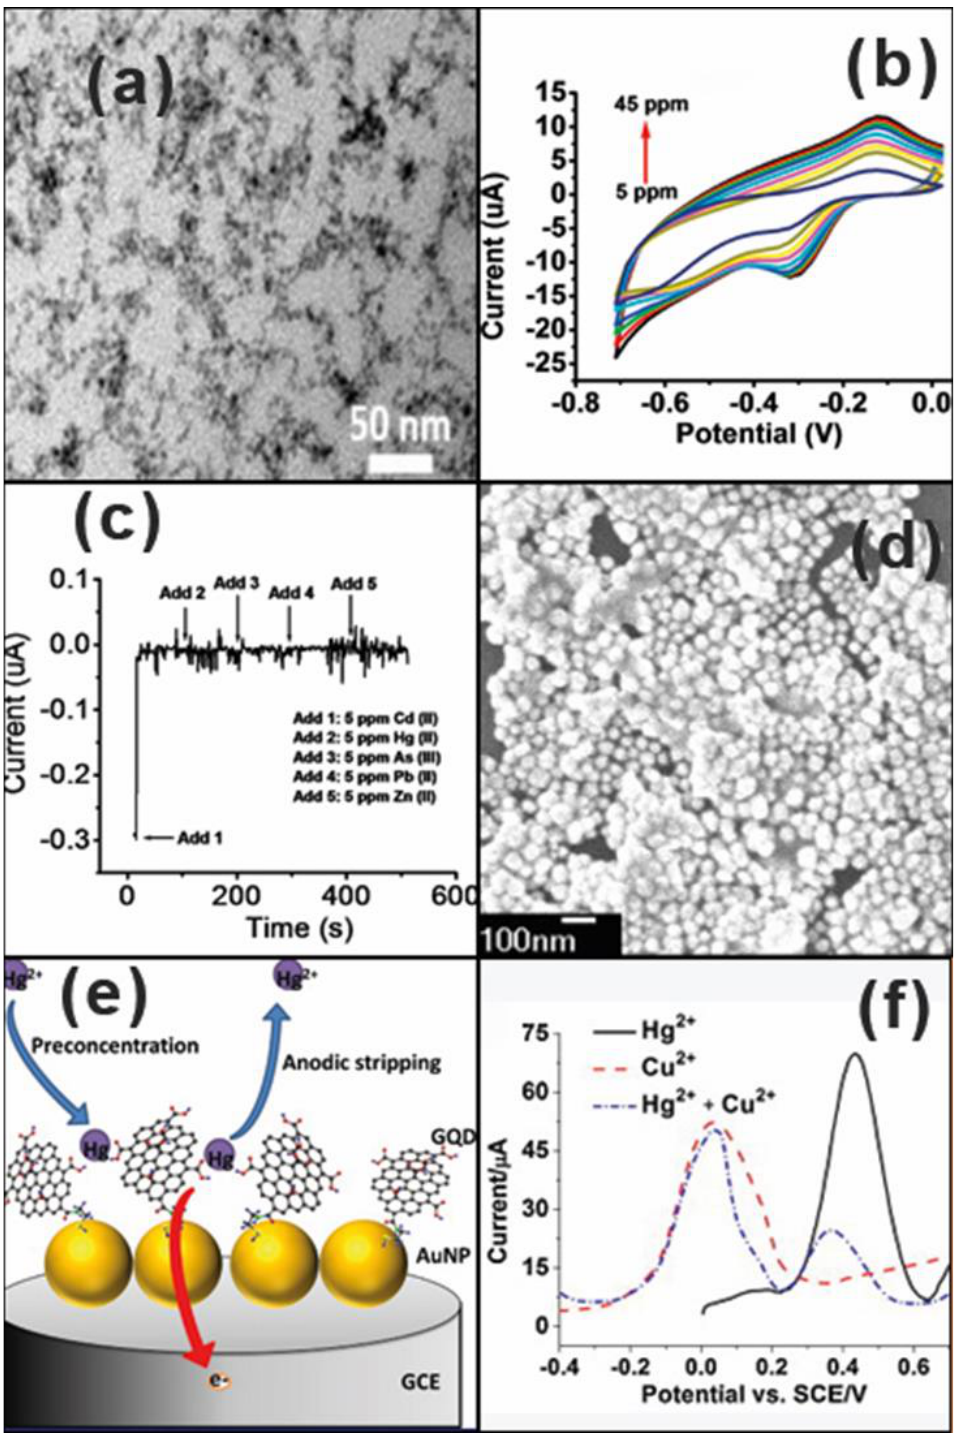
Figure 1. ( a ) HR-TEM image of SnO 2 QD; ( b , c ) CV and selective Amperometric response of SnO 2 /Nafion/Au electrode for detection of Cd ions [29]; ( d ) SEM image of GQD-AuNPs on GCE; ( e ) scheme of Hg 2+ detection; and ( f ) anodic stripping response of 0.5 μM Hg, 0.5 μM Cu ions, and a mixture of both